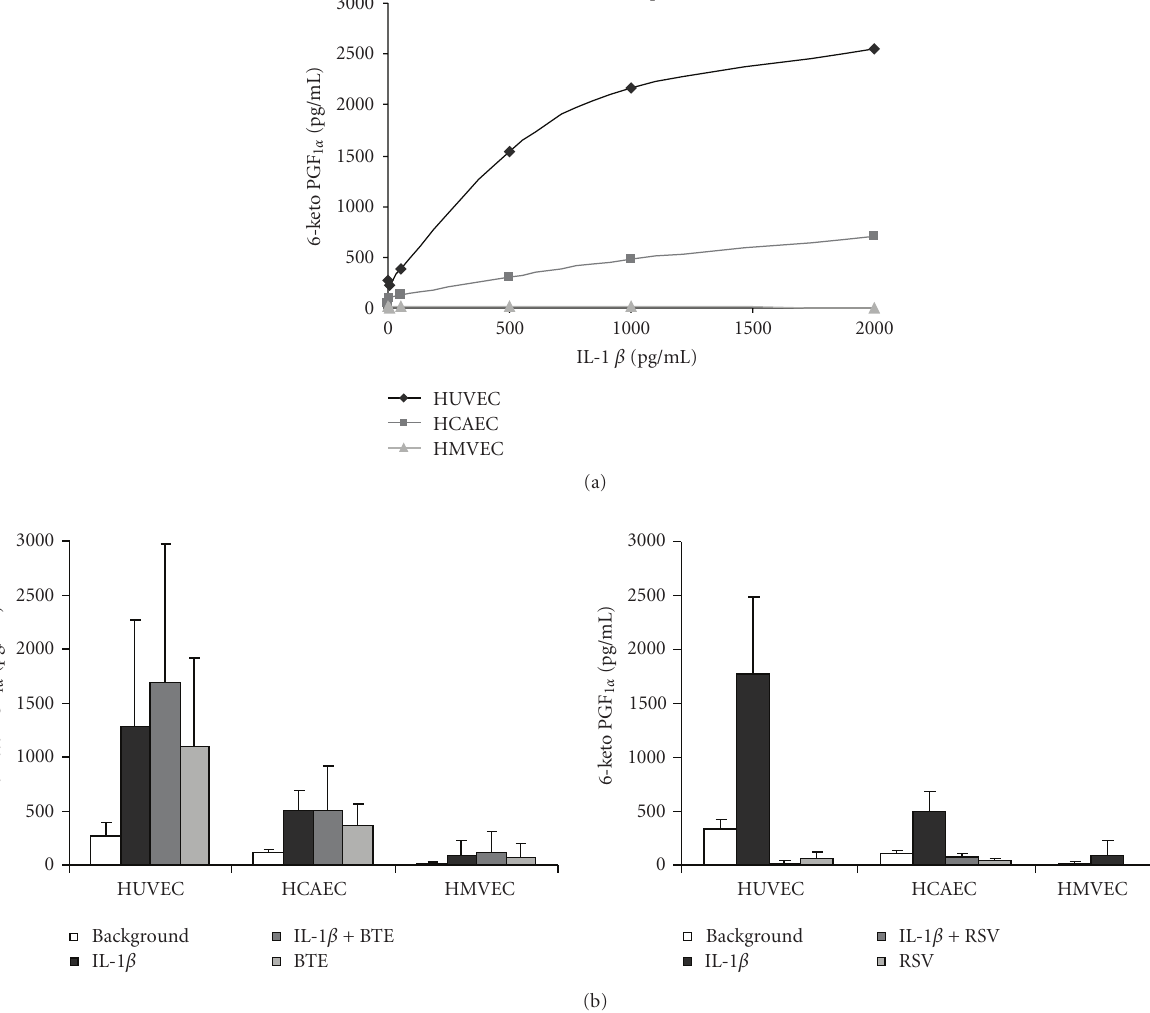
Figure 4: (a) IL-1 β dose-dependent prostacyclin release, as measured by 6 keto-PGF 1 α , from HUVEC, HCAEC, and HMVEC. Concentrations of IL-1 β were 0–2000 pg/mL. Data represent the mean of three separate experiments. (b) PGF 1 α levels measured in the indicated endothelial cell types treated with IL-1 β (1000pg/mL) and/or BTE (40 μ g/mL) [left panel] or IL-1 β (1000 pg/mL) and/or RSV (40 μ M) [right panel]. Data represent the mean ± SD of three separate